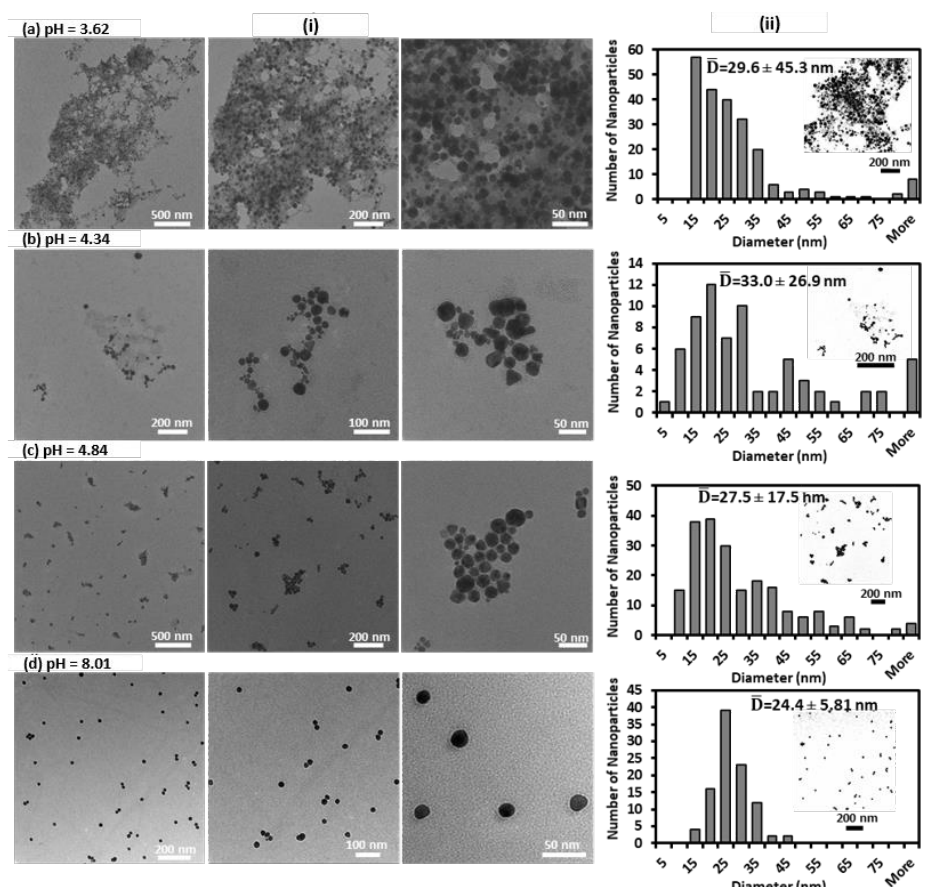
Figure 3. Imaging of the pH-responsive GNPs-MPA solutions: ( i ) TEM micrographs at different scales. ( ii ) Size distribution histograms for pH: ( a ) 3.62, ( b ) 4.34, ( c ) 4.84, and ( d ) 8.01. Inset shows few of the images used for size analysis in ImageJ.